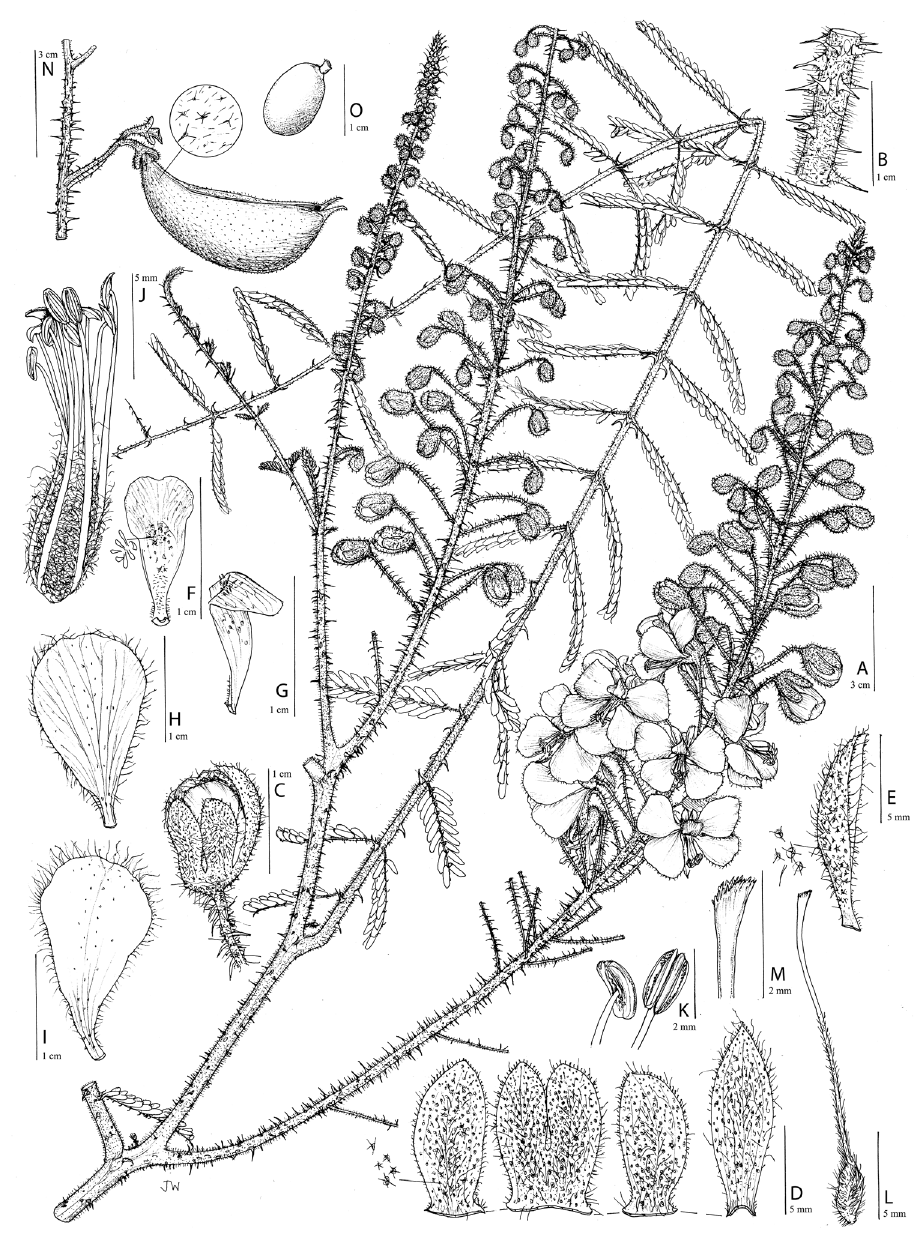
Figure 17. Hultholia mimosoides (Lam.) E. Gagnon & G. P. Lewis. A habit, including foliage and inflo- rescences B stem armature detail C bud showing cucullate lower lobe of calyx D calyx lobes outer surface E calyx cucullate lower lobe side view, F median petal inner surface G median petal side view H upper lateral petal inner surface I lower lateral petal inner surface J stamens K anthers dorsal and ventral views L gynoecium M stigma detail N fruit O seed. A–K from Clark 237 L , M from Beusekom & Geesink 4706 N , O from Bunchuai 1342. Drawn by Juliet